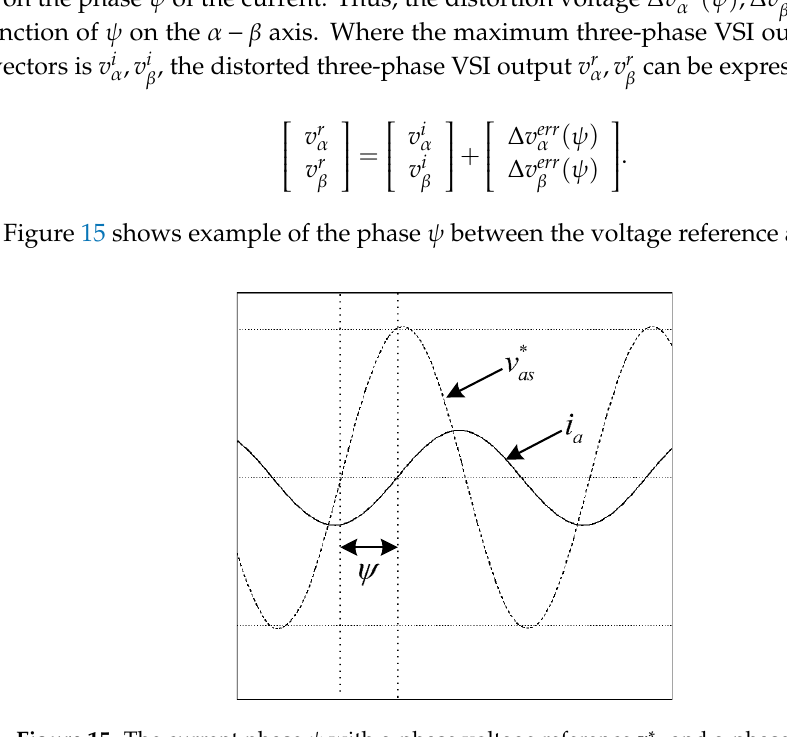
as and a-phase current i a .